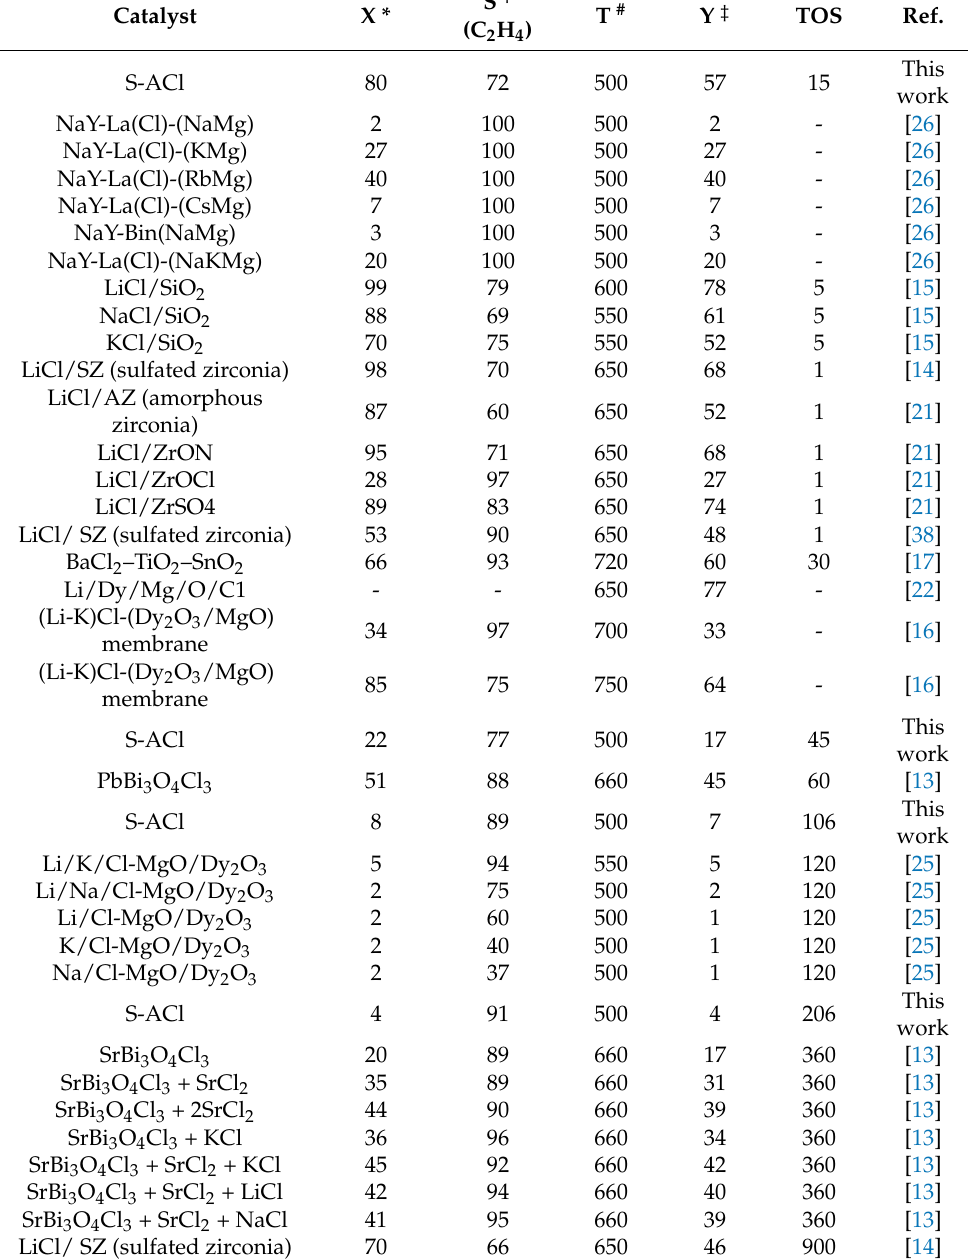
Table 1. Comparison of the catalyst’s behavior in similar research with this study. Catalyst